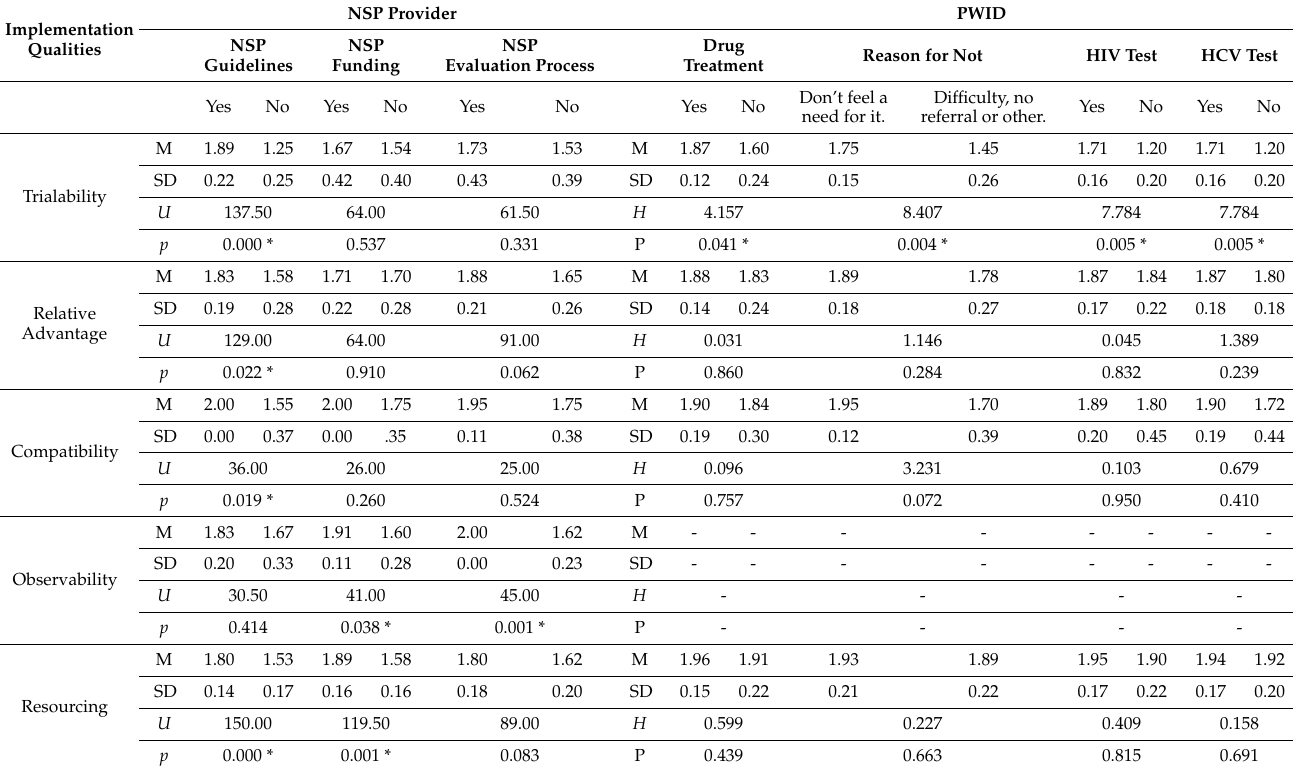
Table 3. Analysis of implementation quality priorities within NSP providers and PWID